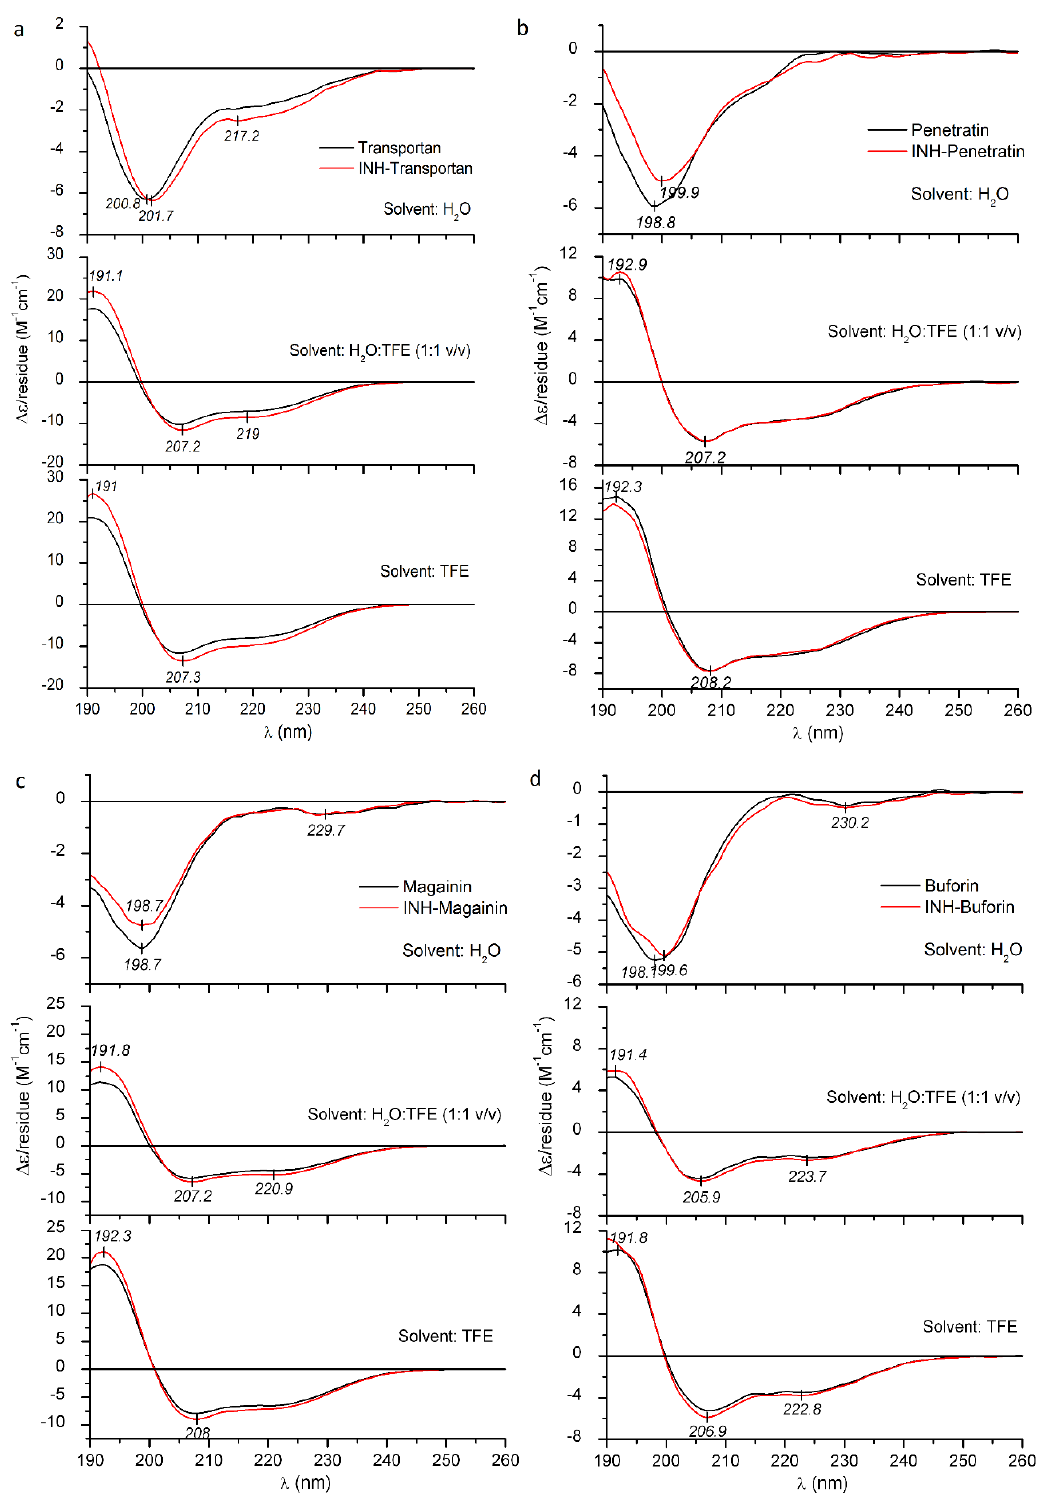
Figure 3. Far-UV CD spectra of Transportan ( a ), Penetratin ( b ), Magainin II ( c ), Buforin II (5–21) ( d ) and their INH conjugates measured in deionized water, TFE and in water:TFE mixture.